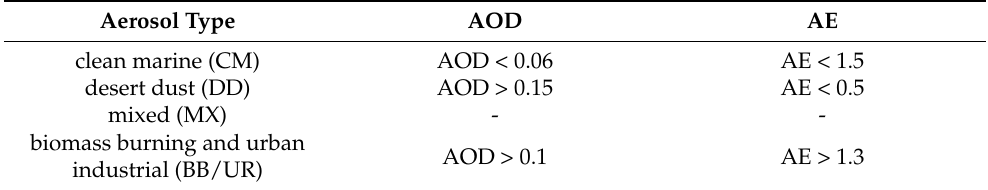
Table 2. Threshold values of aerosol optical parameters to classify aerosol types over study sites. Aerosol Type